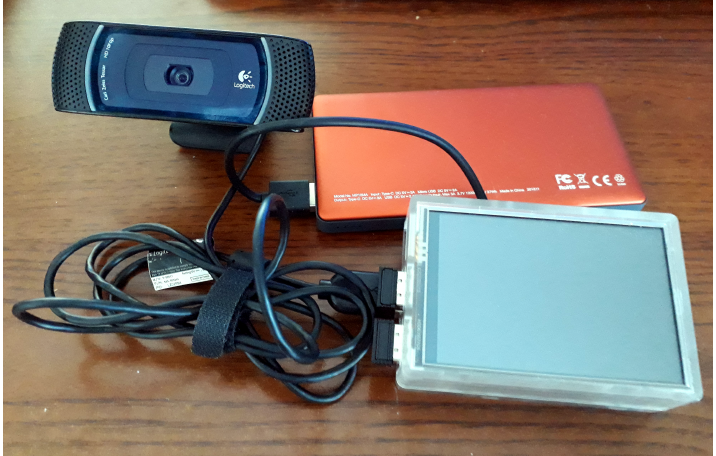
Figure 4. The assembled microcomputer that was used in this research. It consists of a Raspberry Pi 3 model B+ in a semi-transparent case with a 3.5” LCD touchscreen, a Logitech Webcam C920 HD Pro, and a powerbank (5 V, 3